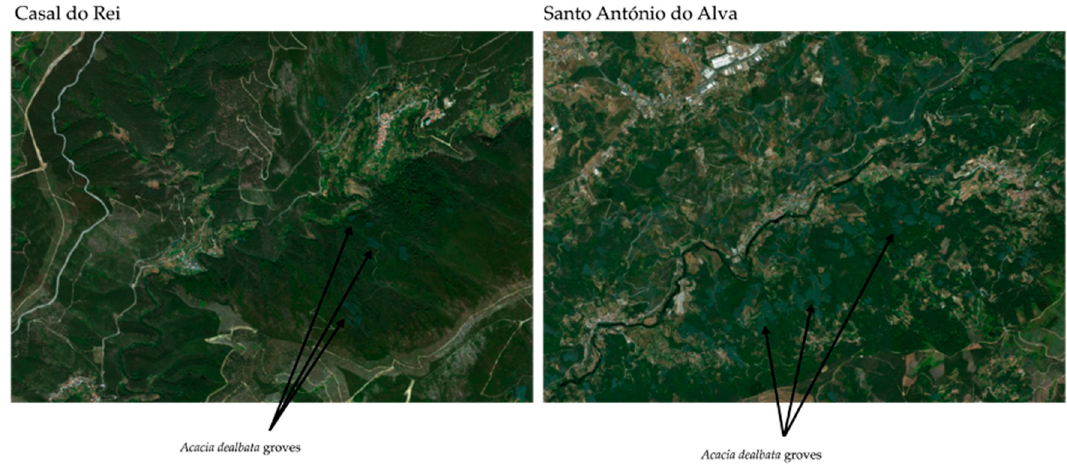
Figure 7. Acacia dealbata groves. As can be seen in the figure on the right, in the Santo António do Alva region, located close to Casal do Rei and also greatly affected by rural fires, one can see a significant dispersion of Acacia dealbata groves, which are replacing eucalyptus and maritime pine areas. These acacia groves are easily identifiable through their shade of green, distinct from other species found in the region.